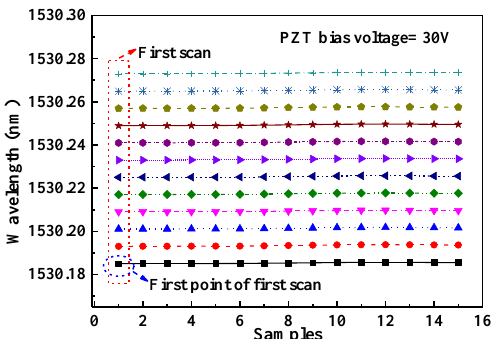
Figure 6. The acquired locking points in 3 scan periods with different PZT bias voltages of 20 V, 30 V and 40 V.